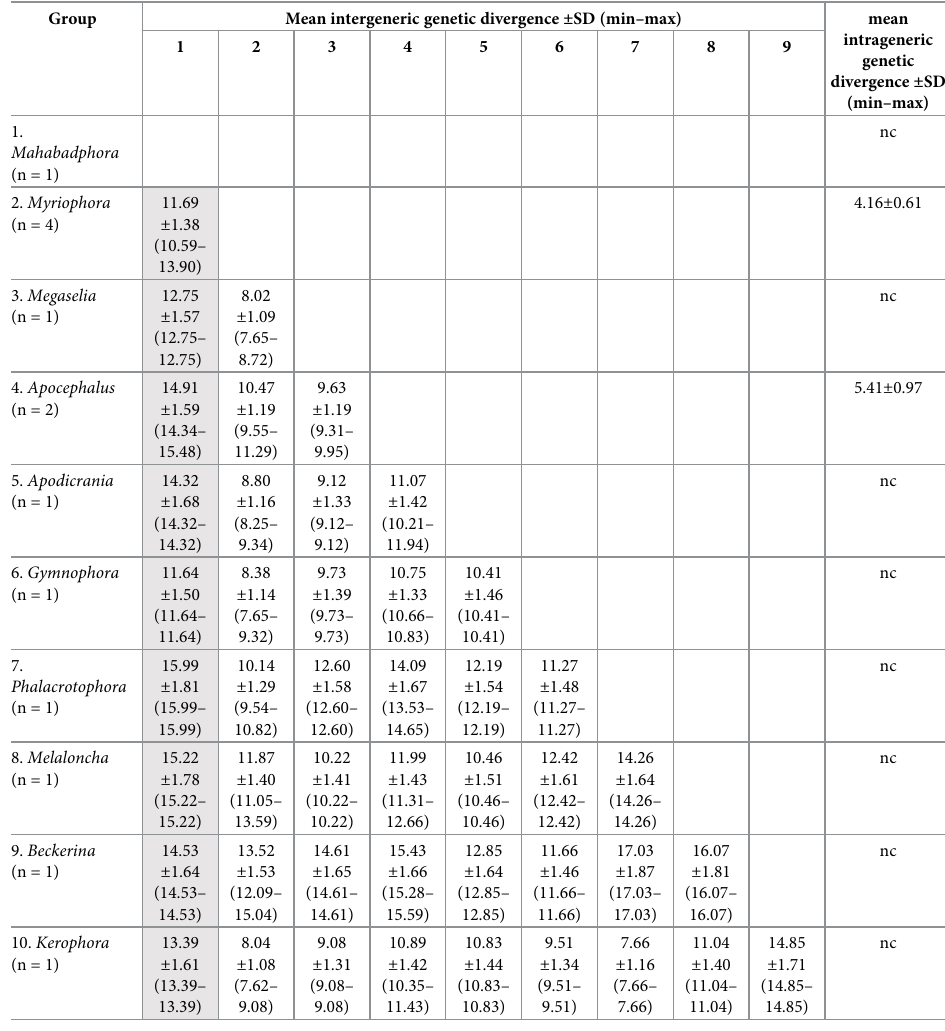
Table 5. K2P genetic distances ± standard deviations (SD) for studied scuttle flies genera based on 543 bps of Arginine kinase